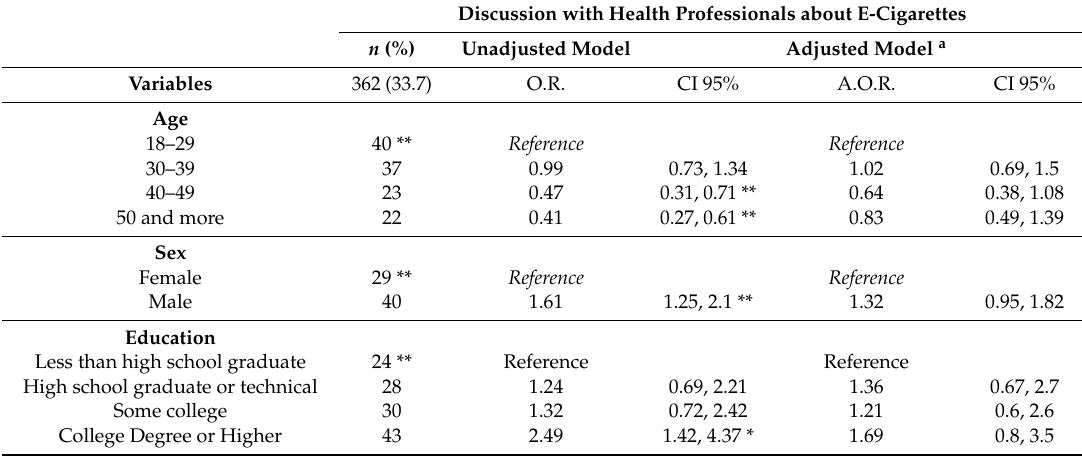
Table 2. Characteristics associated with having a discussion with their HP about electronic cigarettes among adult smokers aged 18 to 71, living in Mexico 2018–2019, ( n =